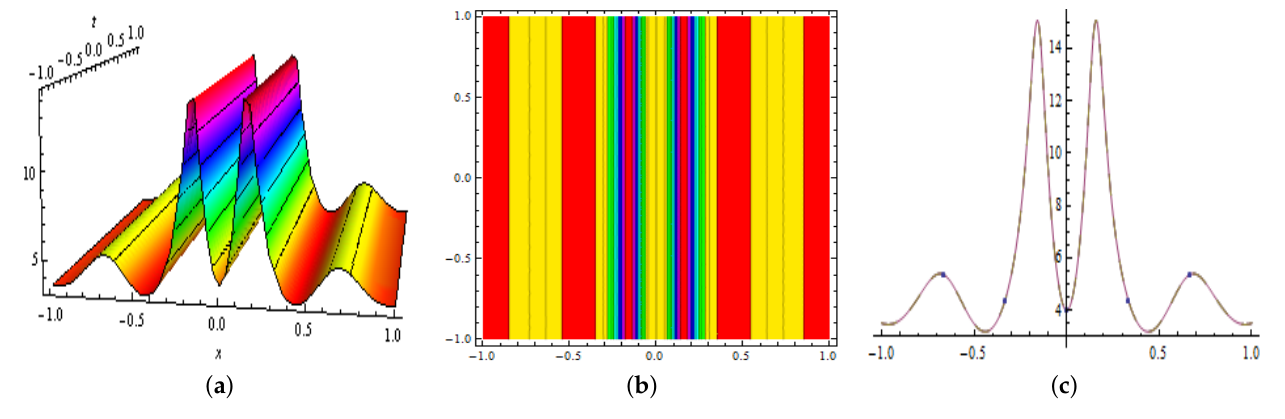
Figure 3. showed three-dimensions in ( a ); contour in ( b ) and two-dimensions in ( c ), Plots of m 31 ( x , t ) in Equation (24) for a = 0.2, b 3 = 1, b 4 = 2, b 5 = − 4, b 7 = − 3, c = 1, α = 0.6, respectively.